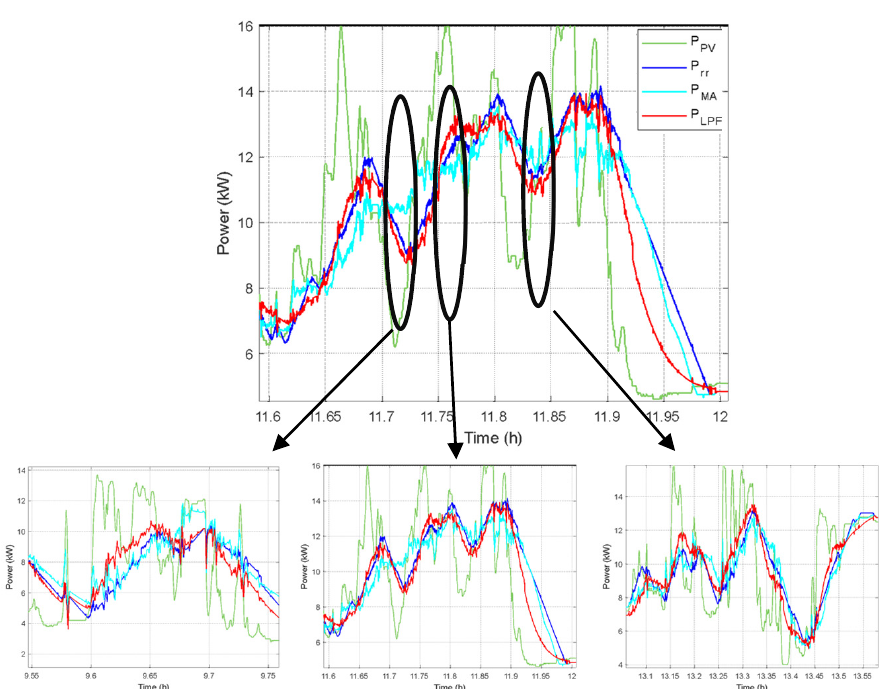
Figure 8. Photovoltaic power and injected power applying the three strategies under study during the most critical day.